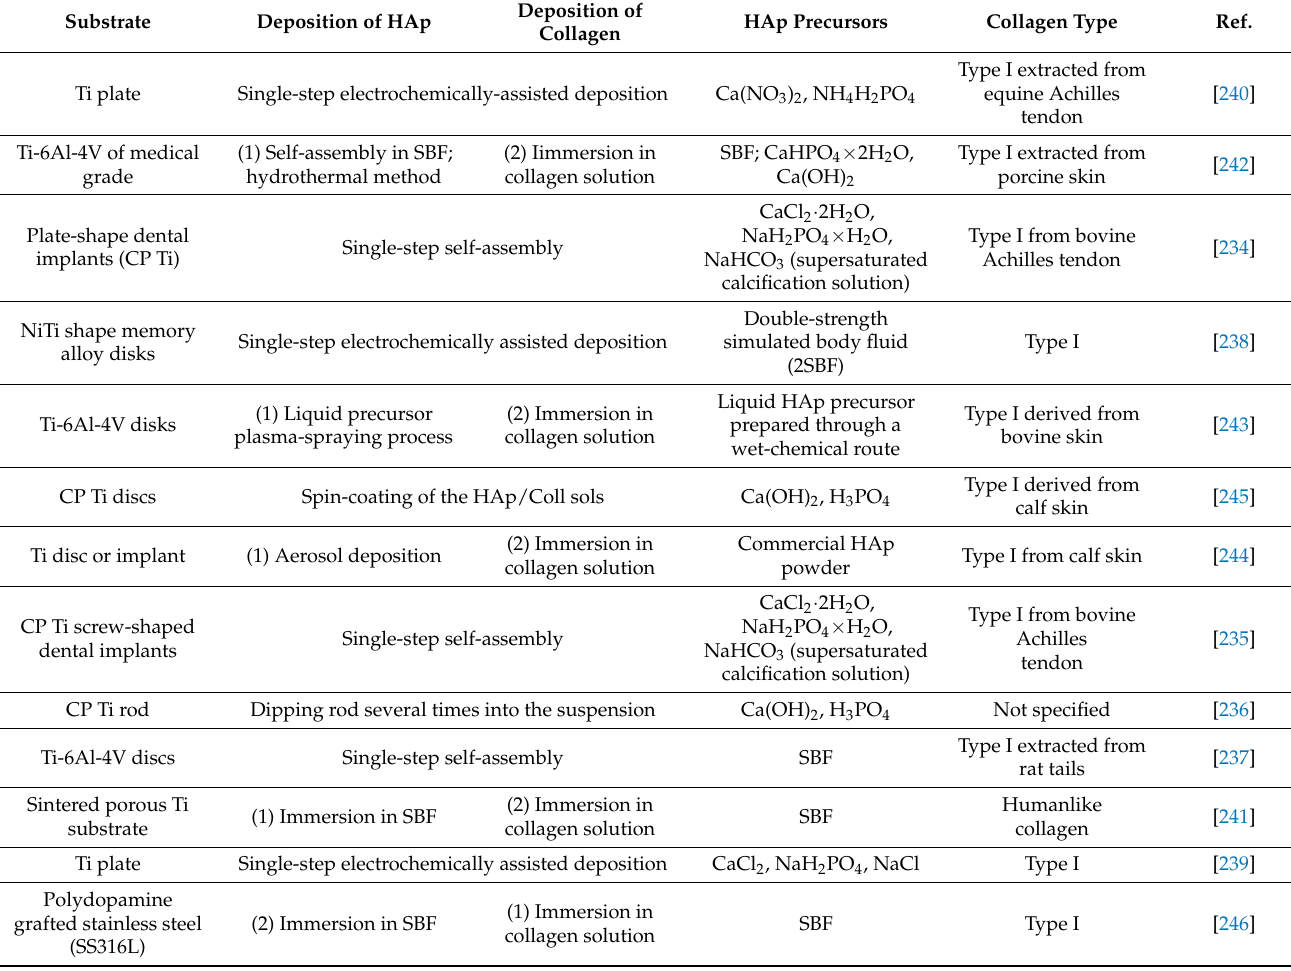
Table 2. Summary of the methods used for HAp/Coll